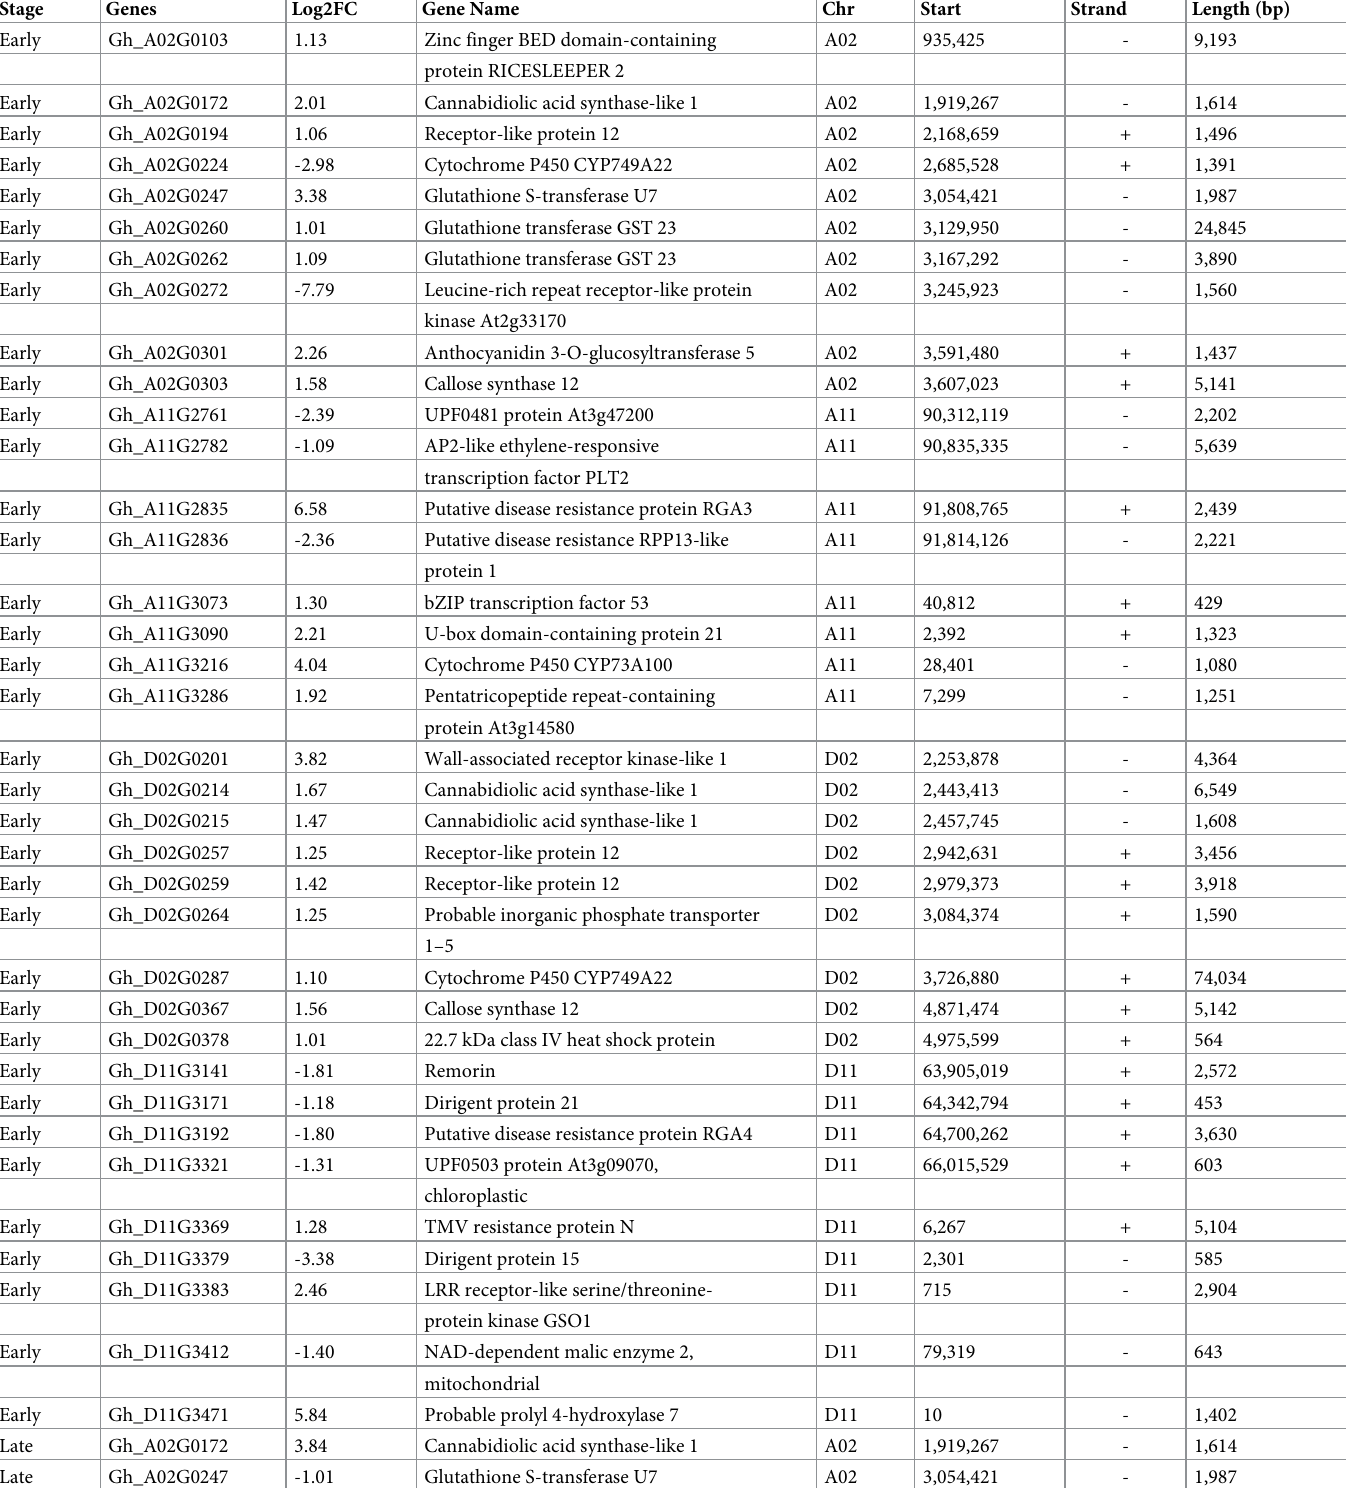
Table 1. Differentially expressing genes in the QTL region between M120 and C201 at early and late stages of RKN